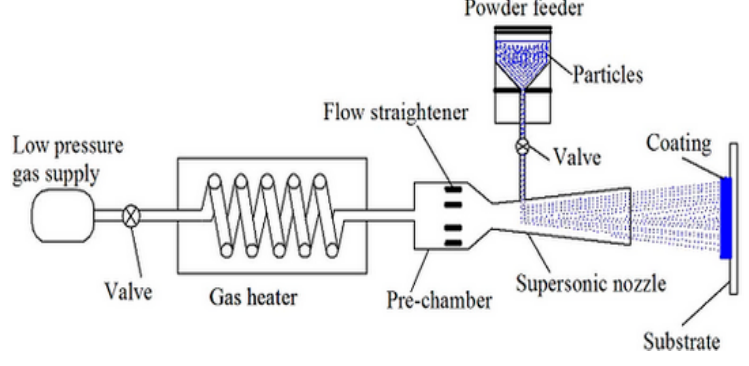
Figure 1. Schematic diagram of the low ‐ pressure cold spray process [25].